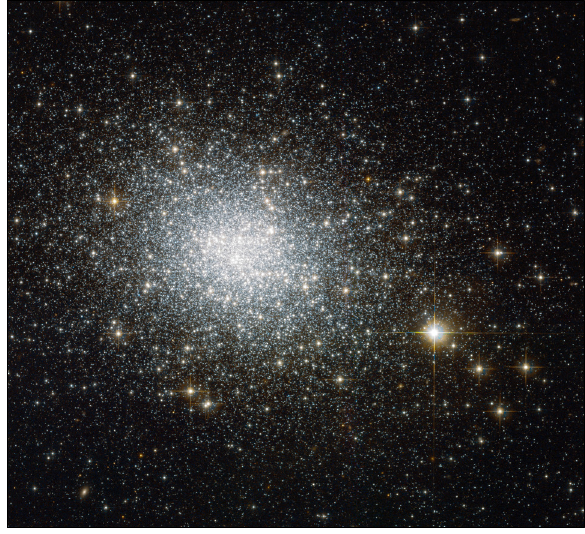
Image CC-BY: ESA/Hubble & NASA, Stefano Campani, 2014 Figure 2: NGC 121, a globular cluster in the Small Magellanic Cloud discovered by John Herschel in South Africa in 1835. It is now recognised as being about 200 000 light years away and about 10 billion years old. Thackeray and Wesselink 6,7 used RR Lyrae variable stars in this globular cluster to double the size and age of the universe as perceived in 1952, when results obtained from the Radcliffe Observatory in Pretoria were announced at a conference of the International Astronomical Union in Rome, supplementing data obtained by Walter Baade and Edwin Hubble who studied the Andromeda Nebula (M31) at the Mount Wilson Observatory in California. Variable stars in NGC 121 had been studied by Henrietta Leavitt in 1912 to determine a period- luminosity relationship. Harlow Shapley was able to calibrate the relationship to estimate distances of stars of variable